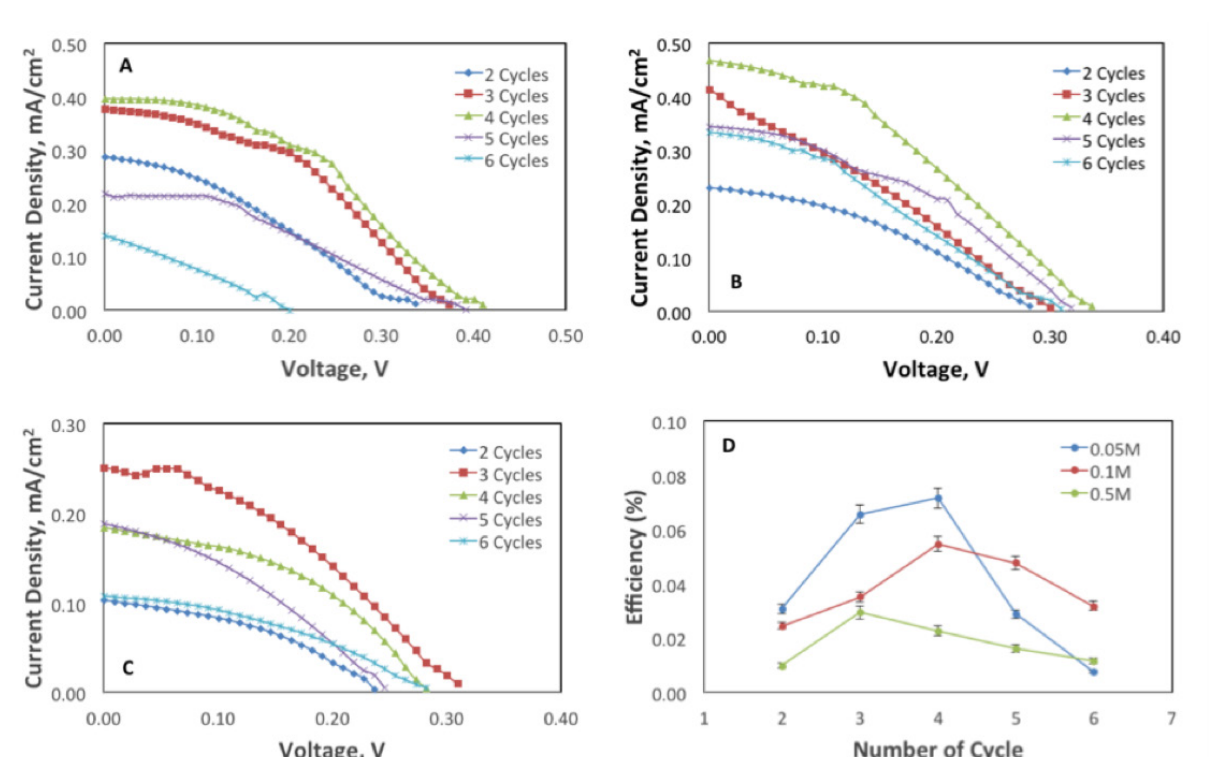
Figure 3: J-V curves for SnS QDSSC prepared from (a) 0.05 M precursor concentration; (b) 0.1 M precursor concentration; (c) 0.5 M precursor concentration with various dipping cycles. The efficiency trend is shown in (d).